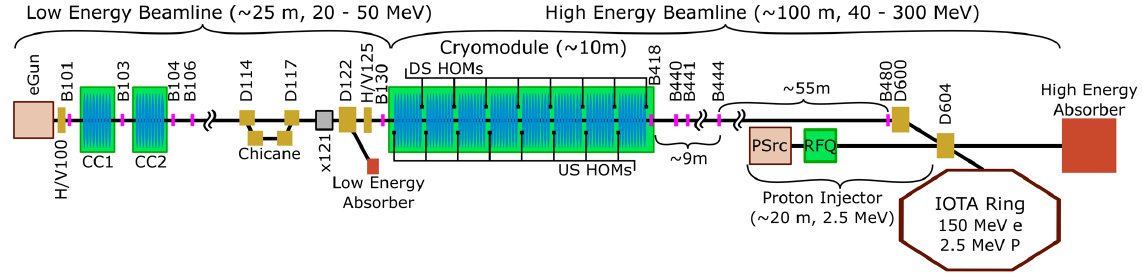
FIG. 1. FAST Linac showing the locations of the rf PC gun, CC1 and CC2 single cavities, the rf BPMs (Bnnn), the H = V 125 correctors, the cryomodule CM2 with 8 cavities and 16 HOM couplers, and high-energy beamline. This schematic is not